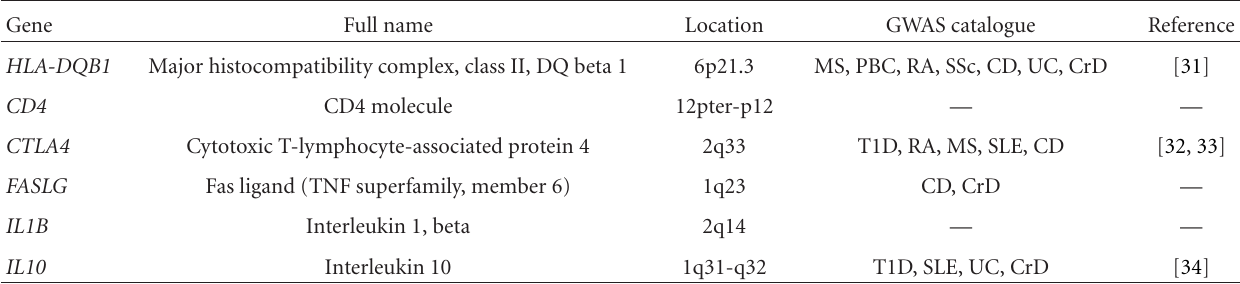
Table 5: Relevance on autoimmunity GWAS of the genes with a contribution higher than 1% to two or more clusters of the studied autoimmune diseases.